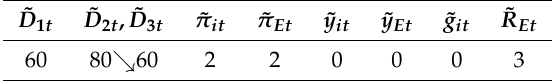
Table 4. Target values for the asymmetric monetary